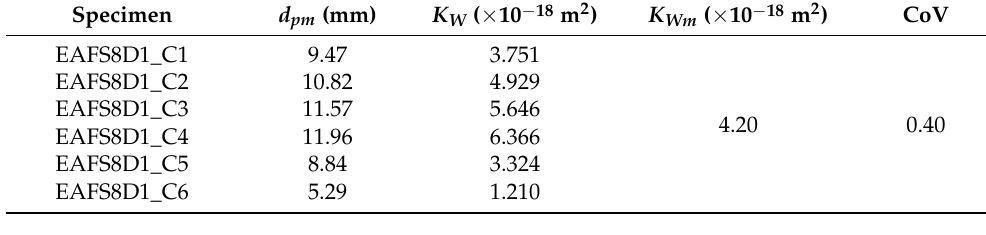
Table 17. Results of water permeability obtained for EAFS8D1 mixture.